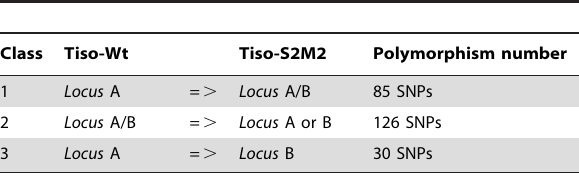
Table 2. Genotype class of polymorphic loci between wild type Tiso-Wt and selected